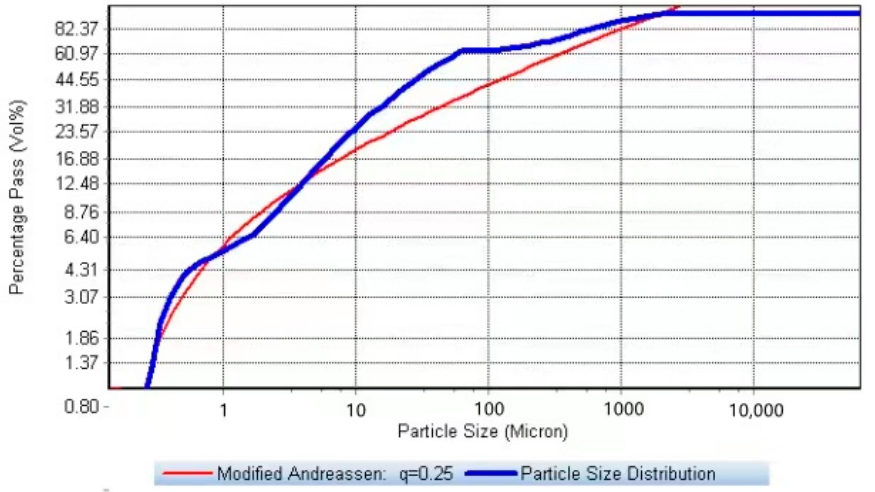
Figure 13. Comparison of the combined particle size distribution of all dry ingredients after adding silica fume and the optimum distribution suggested by the Andreassen model. Reprinted with permission from ref. [68]. Copyright 2018 Elsevier